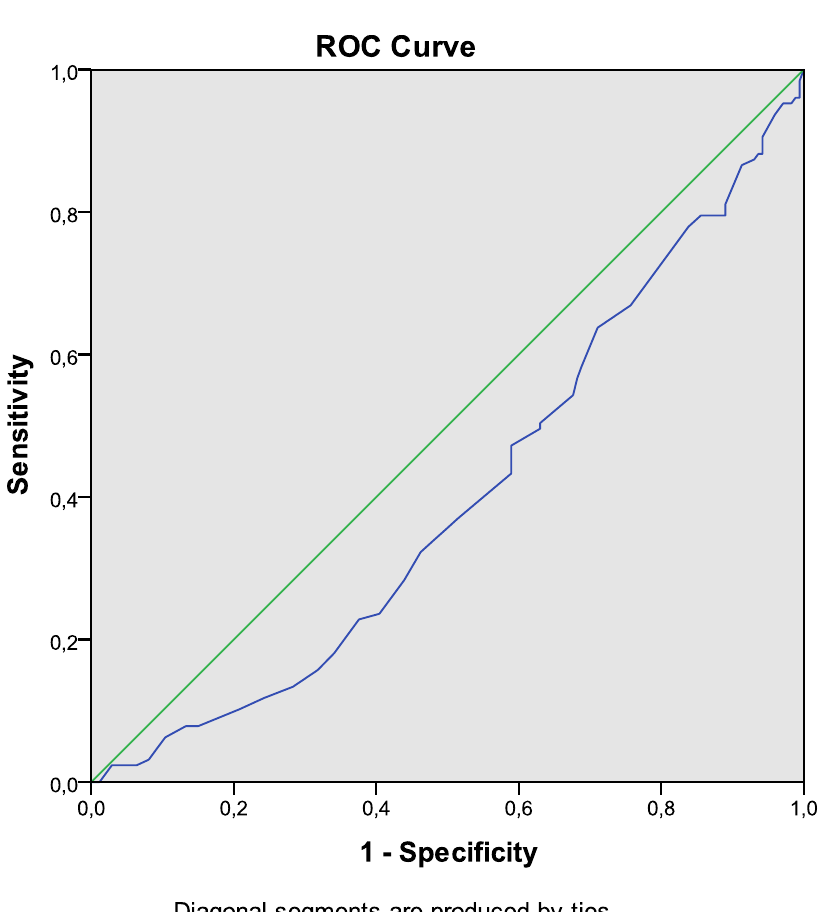
Fig 1. The receiver operating characteristic curve of the Mediterranean diet